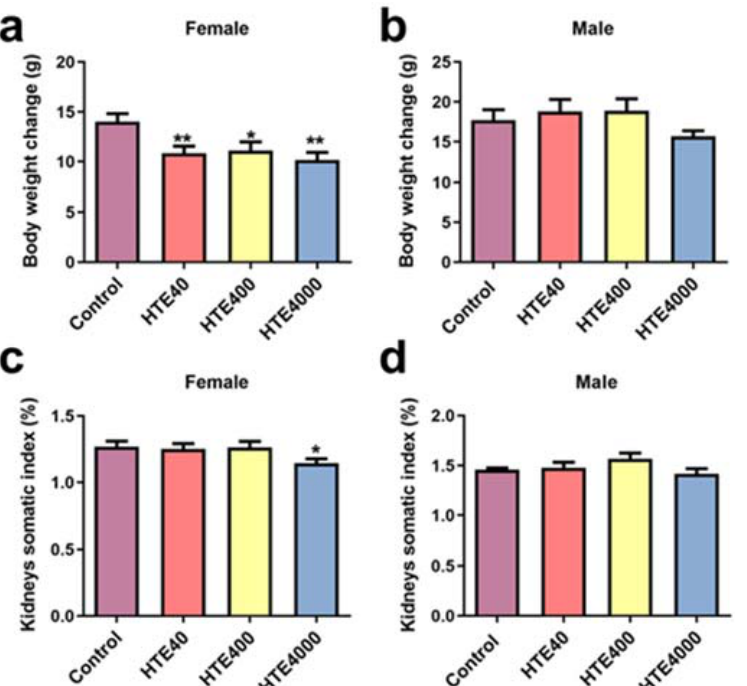
Figure 1. Effect of HTE (40, 400 and 4000 mg/kg) on the body weight and kidney somatic index in the subacute administration study. All data are presented as the mean ± SEM ( n = 10). ( a ) The body weight change of females on the 28th day. ( b ) The body weight change of males after 28 days. ( c ) Kidney somatic index for females. ( d ) Kidney somatic index for males. Statistical significance was analyzed by using the Student’s t -test. Compared with the control, * and ** represent 0.01 < p < 0.05 and 0.001 < p < 0.01, respectively. Table 2. Organ somatic index of HTE (40, 400 and 4000 mg/kg) at the end of the subacute toxicity test.